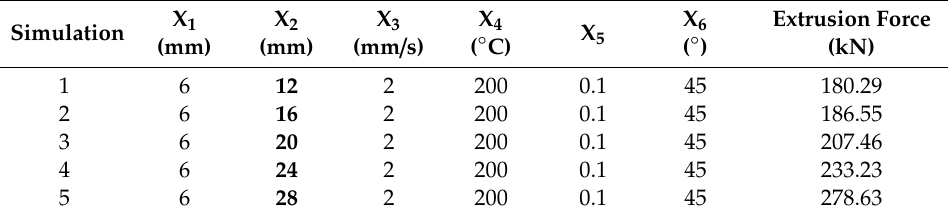
Table 7. Variables combination by varying X 2 (billet height).